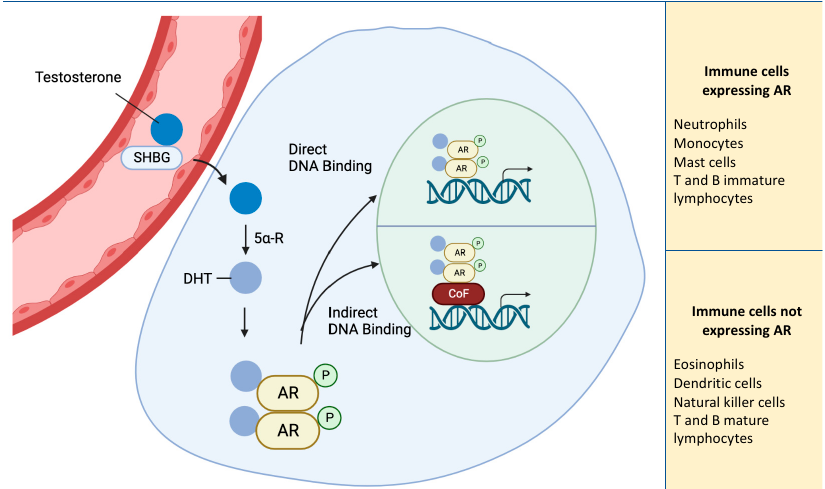
Figure 1. Schematic representation of AR pathway. AR activation by Testosterone, converted to DHT via 5 α -reductase causes receptor dimerization and translocation to the nucleus. In the nucleus, AR binds to DNA directly or through cofactors. Eosinophils, DCs, NKs, and both T and B mature lymphocytes do not express AR and the actions of androgens on these cell types are indirectly mediated. Abbreviations: 5 α -R, 5 α -reductase; AR, androgen receptor; CoF, cofactor; DHT; dihydrotestosterone; P, phosphorylation; SHBG, sex hormone-binding globulin; Testosterone. ARs are expressed in several tissues, mainly in the reproductive organs [14] and also in both myeloid and lymphoid-derived immune cells [15]. They have been identified in the bone marrow (BM) of men and women, and in stromal cells, endothelial cells, macrophages, and myeloid precursors [16].